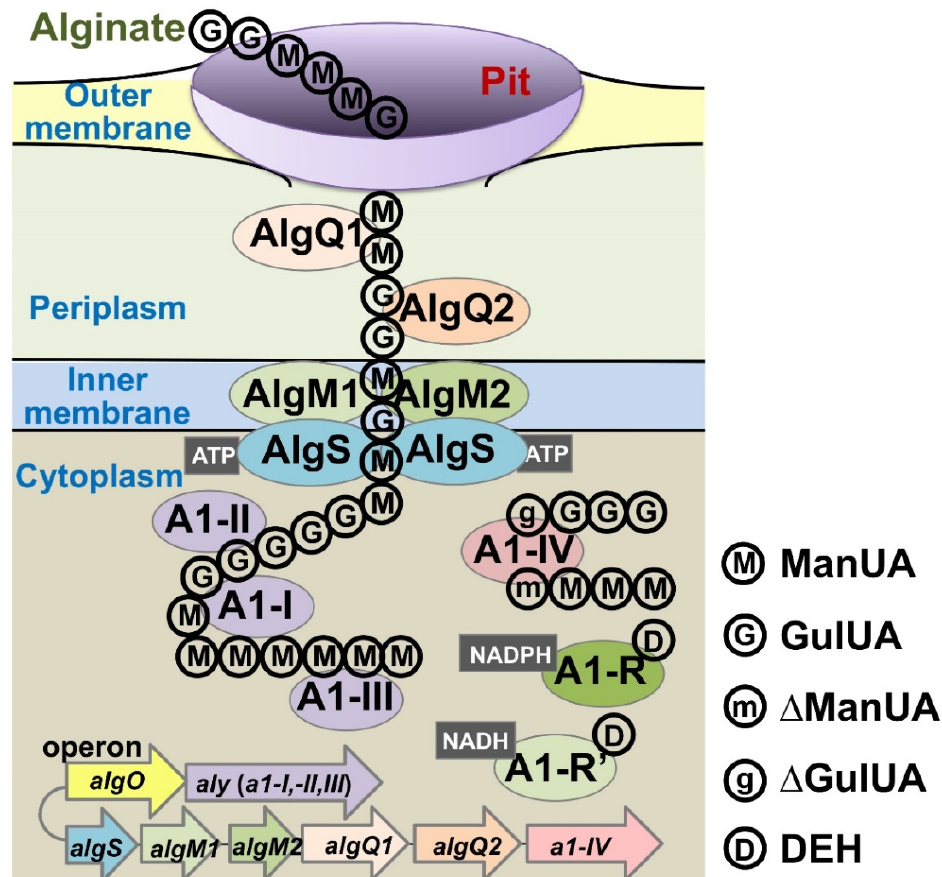
Figure 4. Schematic of import and degradation of alginate by strain A1. Extracellular alginate is concentrated in the cell surface pit and incorporated into the periplasm by an outer-membrane transporter. Periplasmic alginate-binding proteins (AlgQ1 and AlgQ2) deliver the polymer to an inner-membrane-bound ABC transporter (AlgM1–AlgM2/AlgS–AlgS). The ABC transporter incorporates alginate into the cytoplasm by energy generated through ATP hydrolysis. Alginate is degraded to constituent monosaccharides by endo-type (A1-I, A1-II, and A1-III) and exo-type (A1-IV) alginate lyases. The monosaccharides (unsaturated mannuronate and guluronate) are converted to DEH, which is reduced to KDG by DEH reductases (A1-R and A1-R’). Strain A1 operon genes for proteins and enzymes involved in import and degradation of alginate are expressed under the control of the transcriptional factor AlgO. Figure from ref. [36] with modifications.